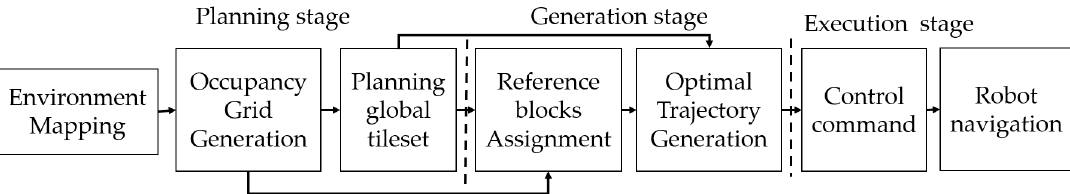
Figure 7. CACP framework for tiling